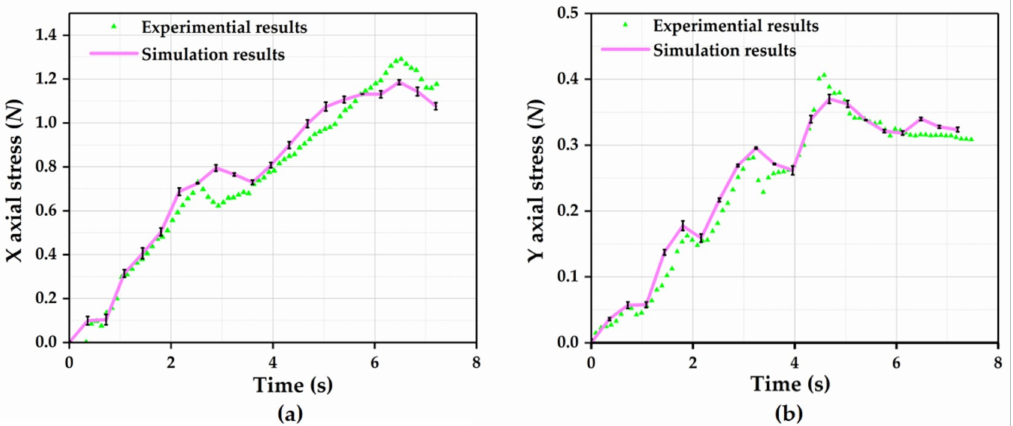
Figure 9. Comparison between model results and experimental results: ( a ) x axial force measured by a sensor in the experiment and obtained by simulation; ( b ) y axial force measured by a sensor in the experiment and obtained by